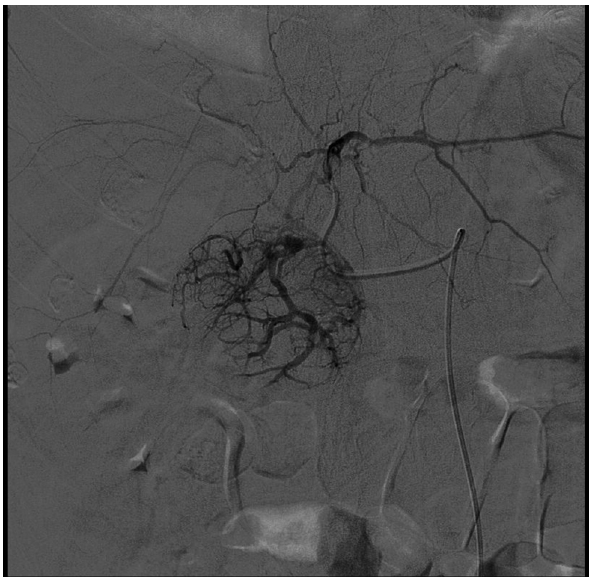
Figure 2: Expansive lesion of the IV hepatic